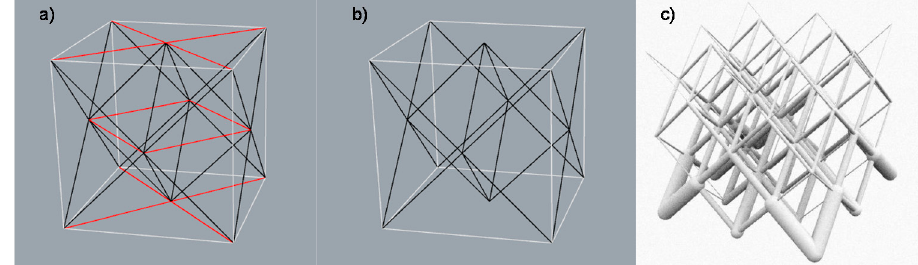
Figure 3. ( a ) Octet-truss unit cell structure; ( b ) Unit cell applied to the case of study; ( c ) Size optimization done to the resultant lattice structure.